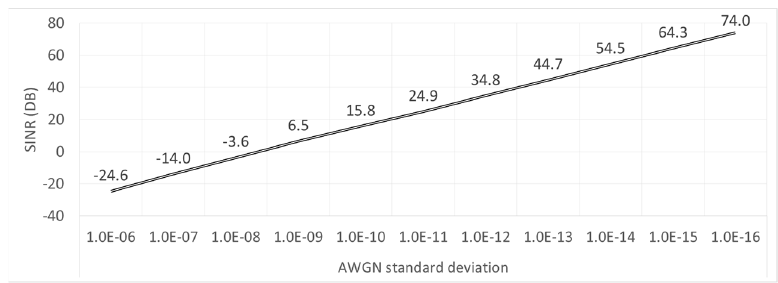
Figure 11. SINR (dB) vs. AWGN standard deviation.